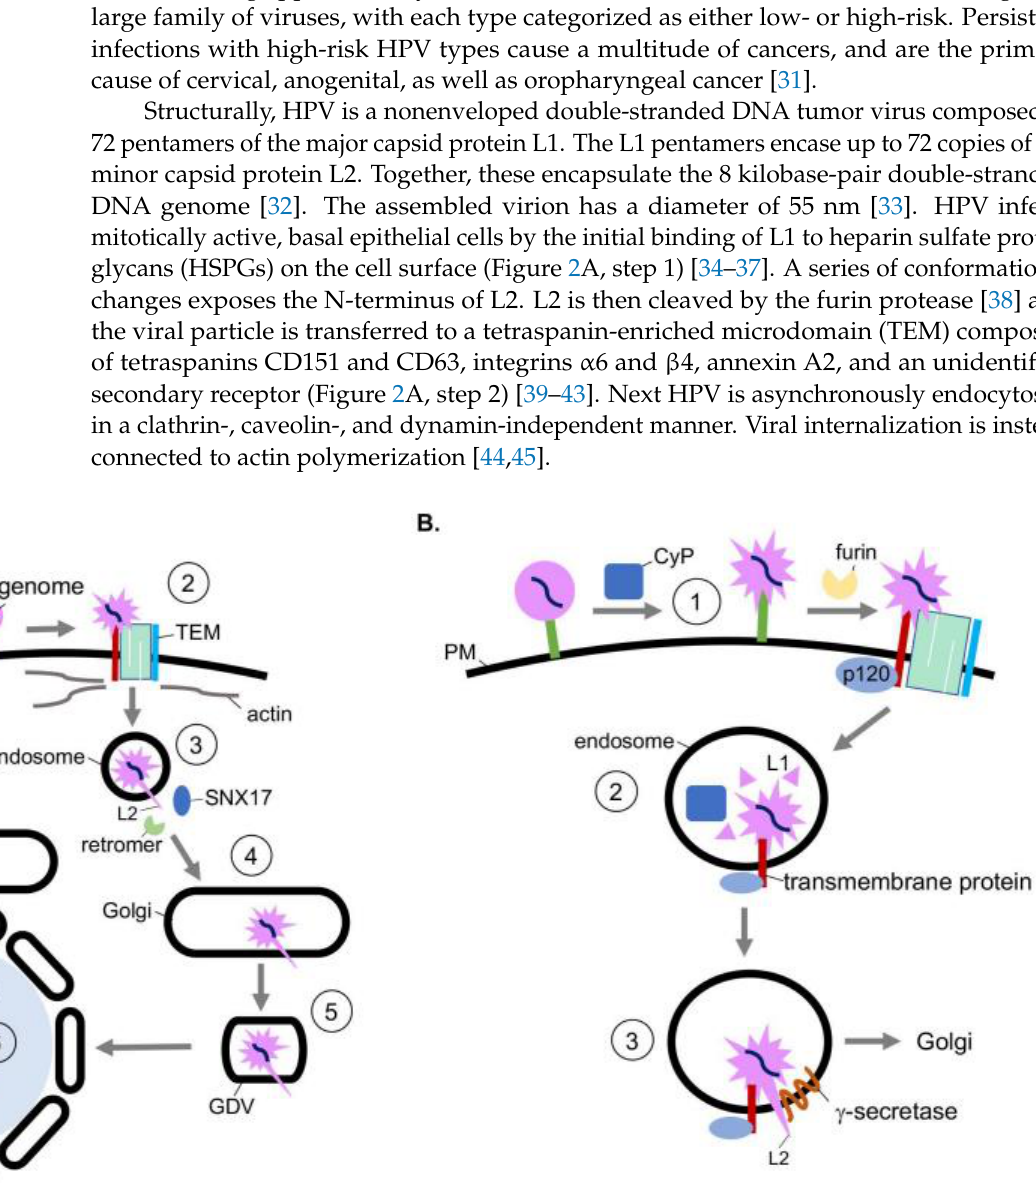
Figure 2. Co-opting soluble and transmembrane chaperones during internalization, disassembly, and endosomal membrane insertion of human papillomavirus. ( A ) HPV entry pathway. During entry, HPV undergoes receptor-dependent endocytosis, transporting to the endosome and then the Golgi. HPV then buds from the Golgi during mitosis, entering the nucleus after nuclear membrane breakdown to cause infection. ( B ) At the plasma membrane, the peptidyl-prolyl isomerase activity of cyclophilins (CyP) induces conformational changes in the viral capsid proteins that expose a furin cleavage site at the N-terminus of L2 (step 1). After furin cleavage, the virus is transferred to the tetraspanin-enriched microdomain (TEM) and endocytosed. In the endosome, cyclophilins mediate partial dissociation of L1 from L2 and the viral genome (step 2), further exposing L2. Additionally, in the endosome, the transmembrane protein γ-secretase interacts with L2 and acts as a chaperone to promote the insertion of the L2 C-terminus across the endosomal membrane (step 3). The cytosol-exposed L2 recruits host sorting factors, which traffic the virus to the Golgi en route for infection.